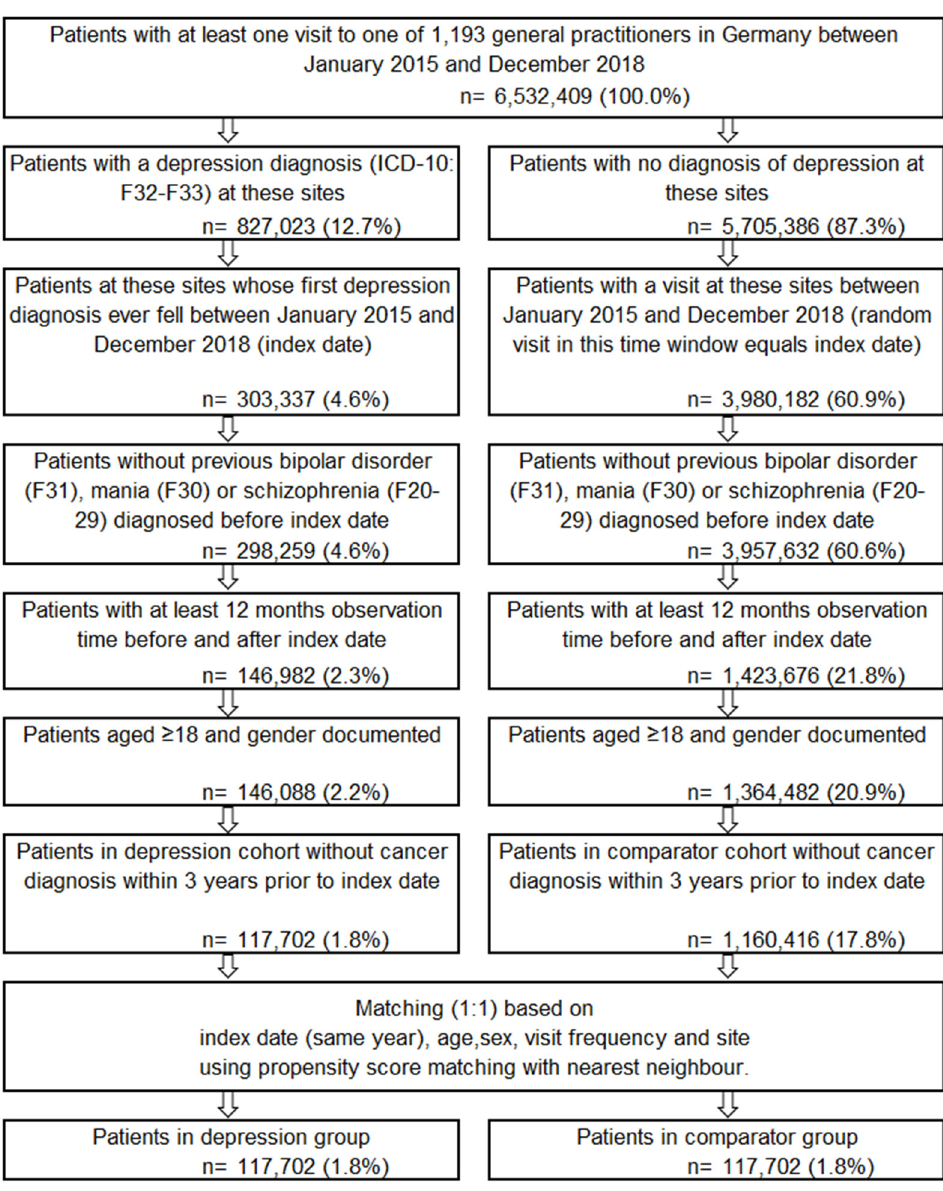
Figure 1. Attrition diagram of study cohort.